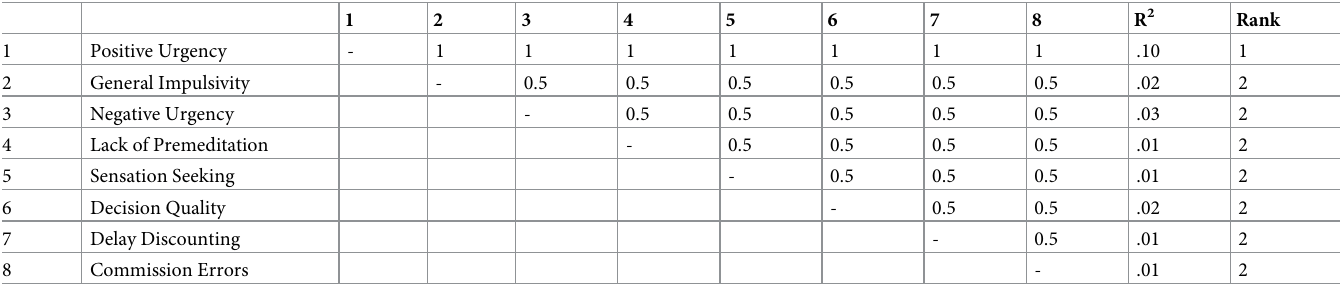
Table 7. Dominance matrix for Model 2 predicting the affective facet arranged by order of complete